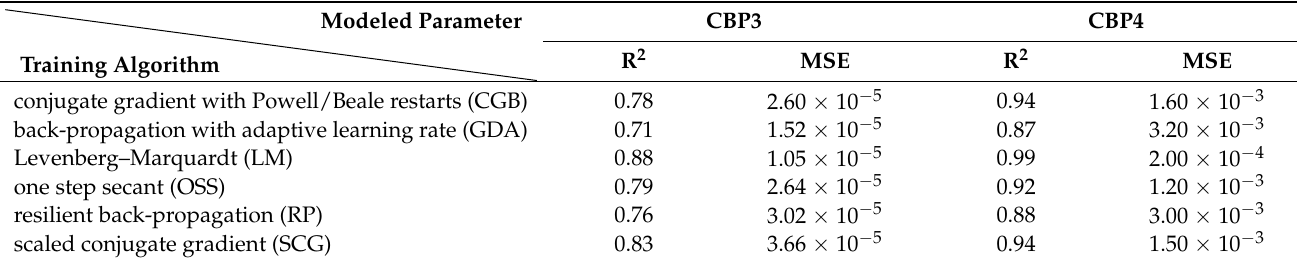
Table 6. Comparison between the performance of various ANN training algorithms for bins 3 and 4.